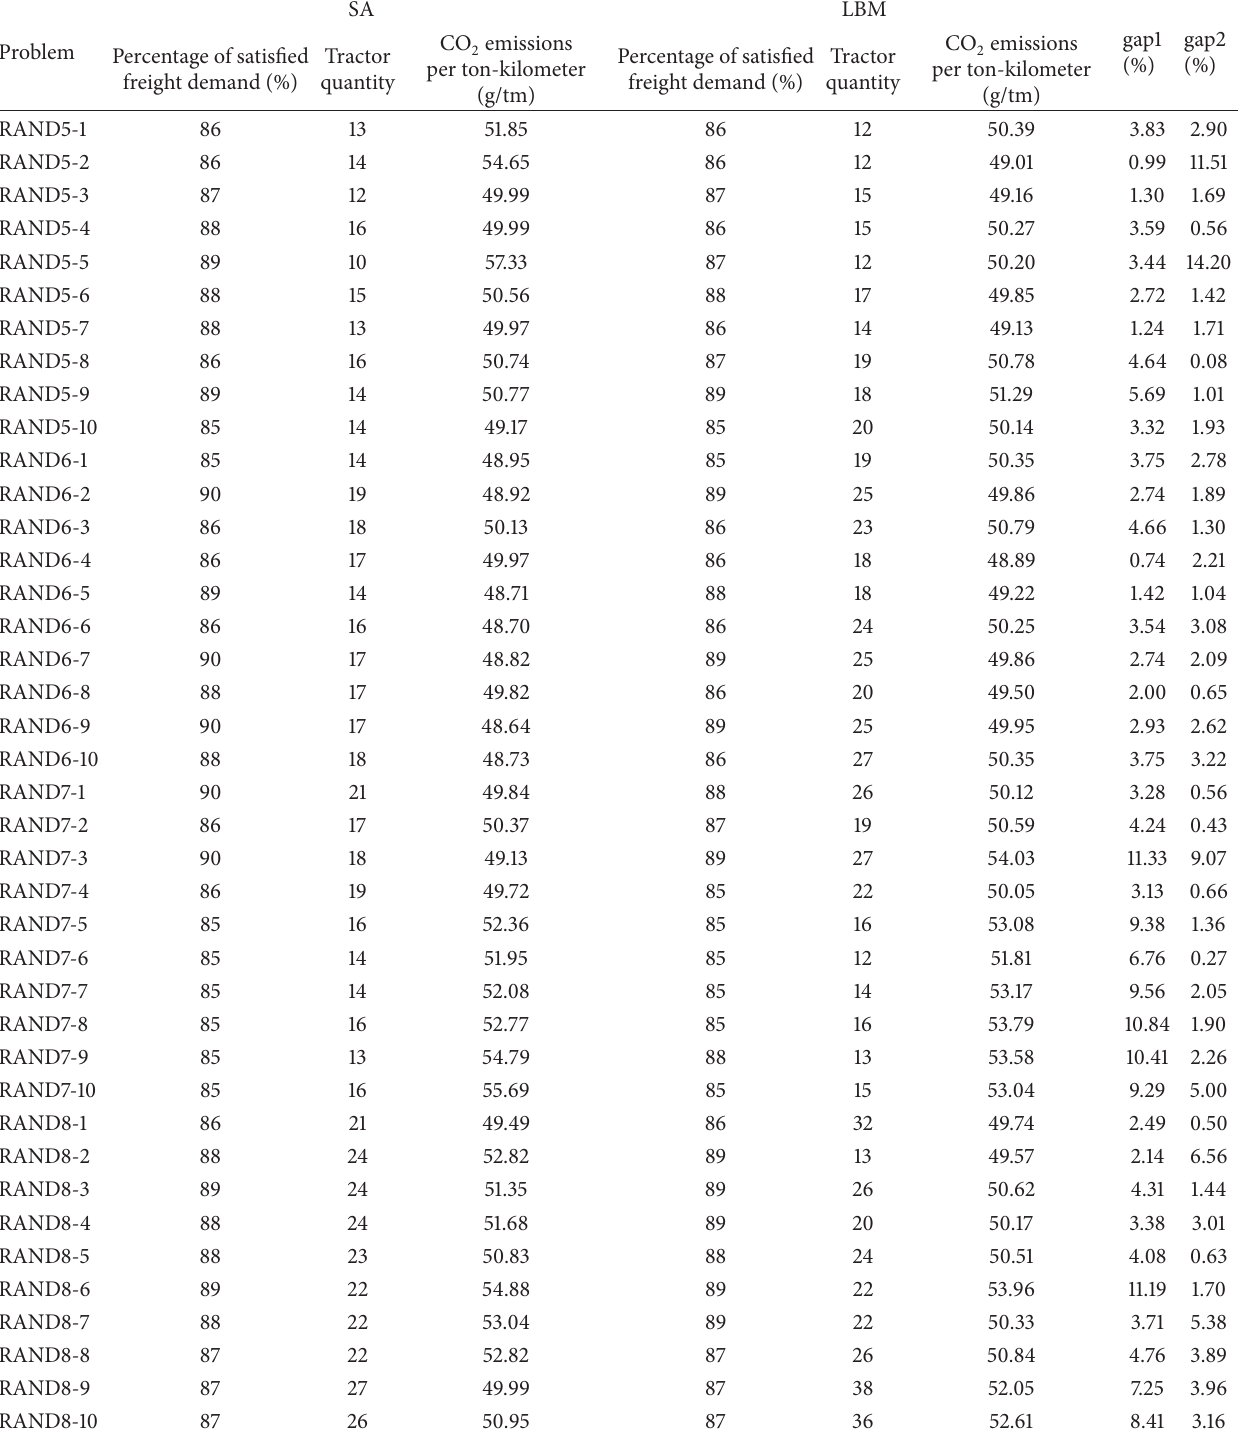
Table 2: Computational results for the 40 test